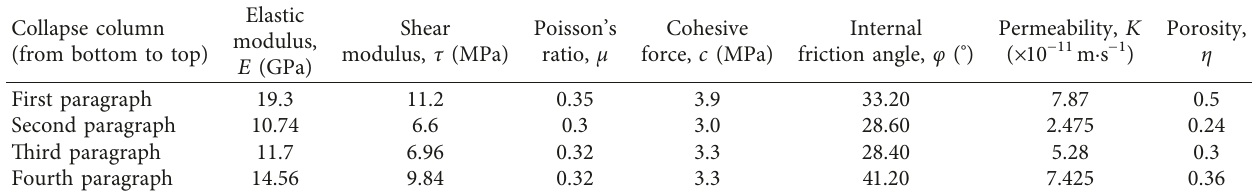
100 groups of data points are taken. The horizontal and